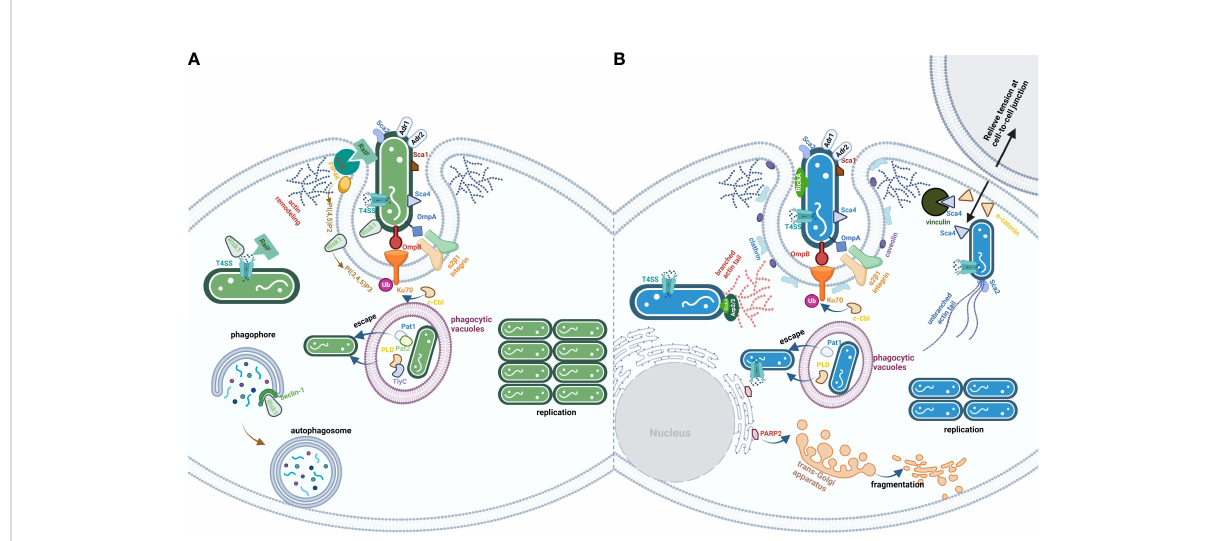
FIGURE 1 The life cycle of TG (A) and SFG (B) rickettsiae. The effectors are exploited by rickettsial species from TG or SFG. (A) is the process of TG invasion of host cells by rickettsial species. Besides Adr1 subversion of complement-mediated killing in serum and a series of Scas and Adr2, bacteria from TG employed multiple PLs (Pat1/2, PLD, and TlyC), kinase (Risk1), and RaIF to disturb host cells PI metabolism. (B) is the process of SFG invasion of the host cells by rickettsial species. The signi fi cant characteristic of bacteria from SFG is the ability to spread before infected cell lysis, which utilizes a series of effectors (RickA, Sca2, and Sca4) to modulate cytoskeletal actin polymerization and PM rearrangement.